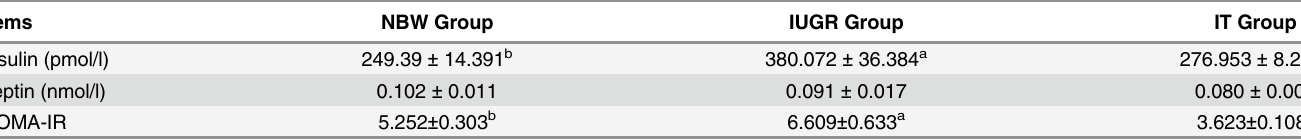
Data are expressed as mean ± SEM, n = 6; SEM, standard error of mean. a,b,c Mean values within a line with different superscript letters were signi fi cantly different ( P < 0.05). NBW, piglets with a normal birth weight that were fed with basic milk diets; IUGR: piglets with intrauterine growth retardation that were fed with basic milk diets; IT, piglets with intrauterine growth retardation that were fed with diets supplemented with 0.1% TB. HOMA-IR = [fasting glucose (mmol/L)×fasting insulin ( μ U/ml)] / 22.5; HOMA-IR, homeostasis model of assessment for insulin resistence